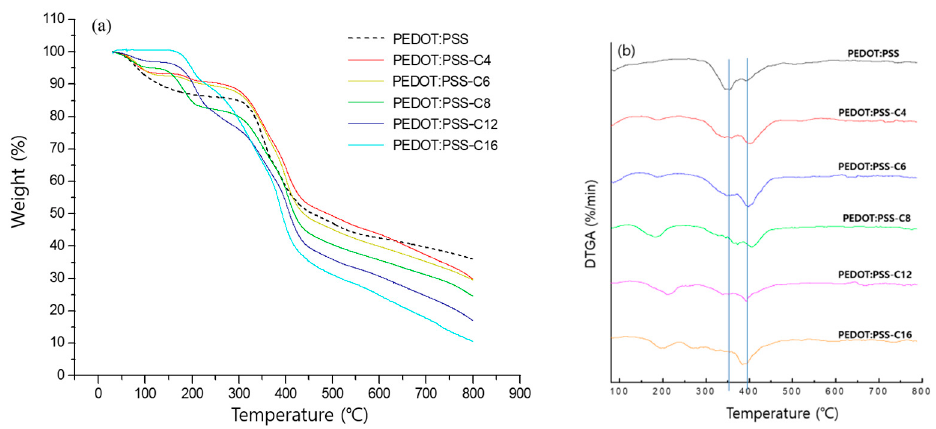
Figure 4. ( a ) TGA curves and ( b ) dTGA curves of PEDOT:PSS and derivatives.